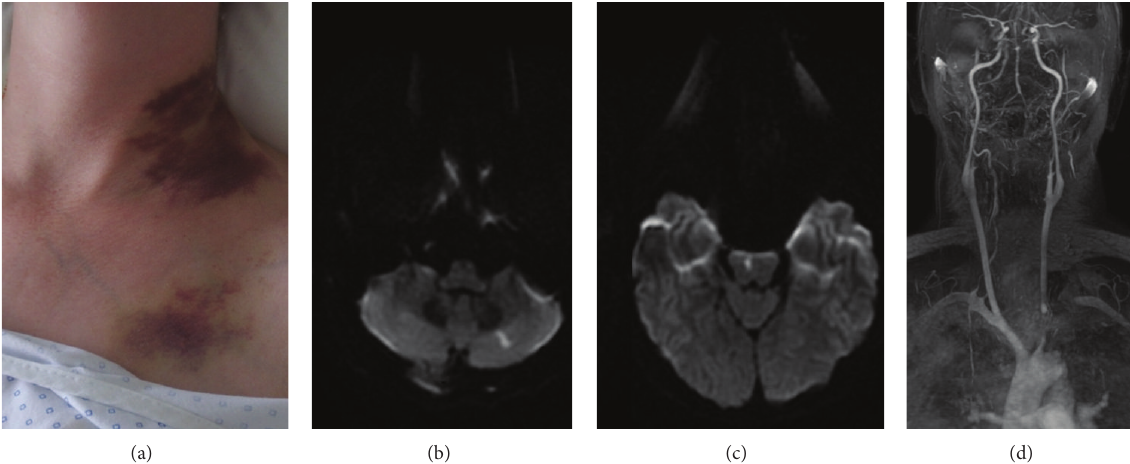
Figure 1: (a) Presence of a left supraclavicular subcutaneous hematoma. ((b), (c)) Diffusion-weighted magnetic resonance imaging showing left cerebellar (b) and right anterior pontine (c) hyperintensities related to limited infarcts in the posterior circulation territory. (d) Magnetic resonance angiography showing only the distal segment (V 4 ) of the left vertebral artery.